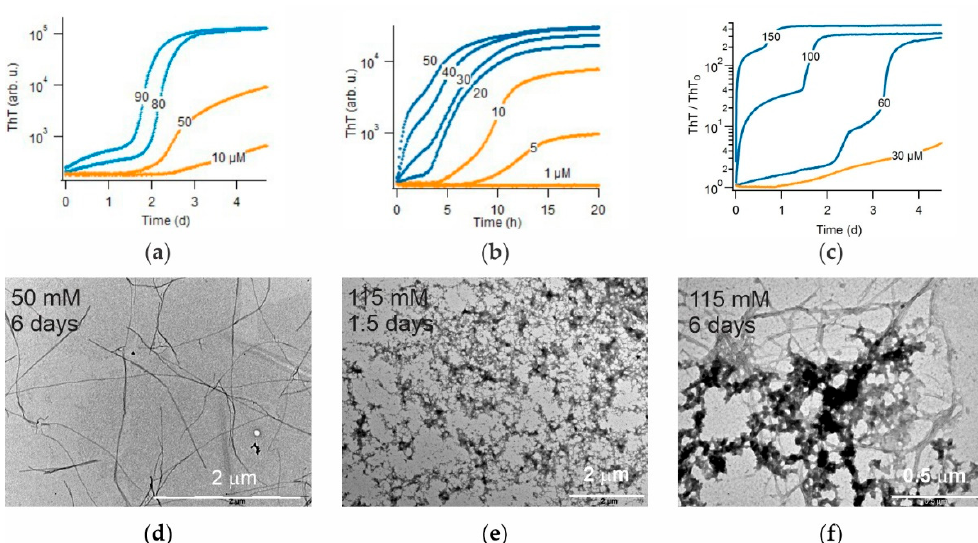
Figure 8. Transition from sigmoidal to biphasic kinetics and associated gO/CF formation for A β 40 and A β 42. ( a ) Transition in A β 40 growth kinetics from pure sigmoidal (orange) to biphasic (blue) kinetics (pH 7.4, no salt). ( b ) Same as ( a ) but for A β 42. Semilog plot emphasizes weak ThT response during gO/CF phase. ( c ) ThT fractional change during A β 40 growth in physiological saline. Notice the significant increase in gO/CF amplitude relative to panel ( a ). ( d–f ) TEM images of samples of ( a ) — A β 40 RFs following sigmoidal growth at 50 μ M ( d ) versus biphasic growth at 150 μ M, with gO/CFs formed within 1.5 days, and ( e ) mixtures of gO/CF and RFs after 6 days ( f ).